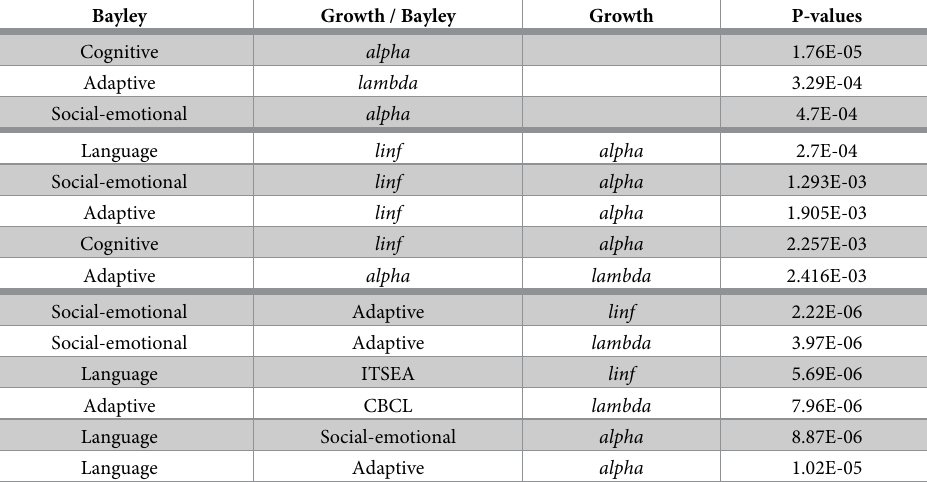
Table 1. Significant dependencies among neurological phenotypes (Bayley) and growth parameters (Growth) with 2-way (top sub-table) and 3-way effects (middle and bottom sub-tables) were